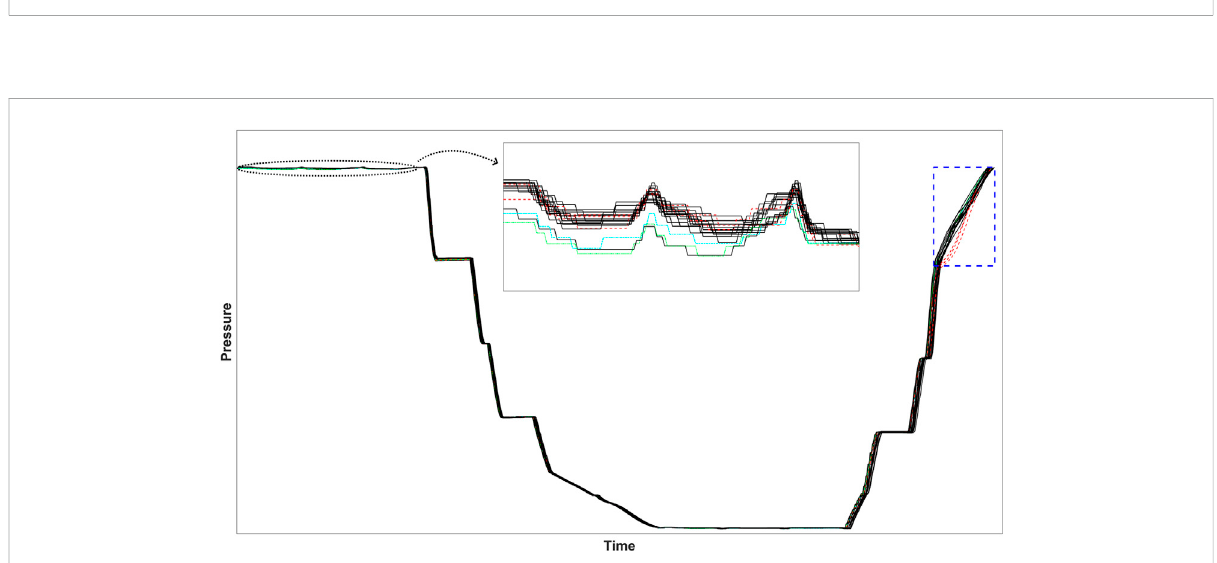
FIGURE 7 The false alarm cycles 10 (in cyan) and 15 (in green) behave normally during the re-pressurization step in which the true fault occurred (highlighted in the blue dashed-line rectangle with faulty cycles plotted as red dashed lines). The zoom-in view of the adsorption step indicates that cycles 10 and 15 are at the lower, but normal, boundary of all